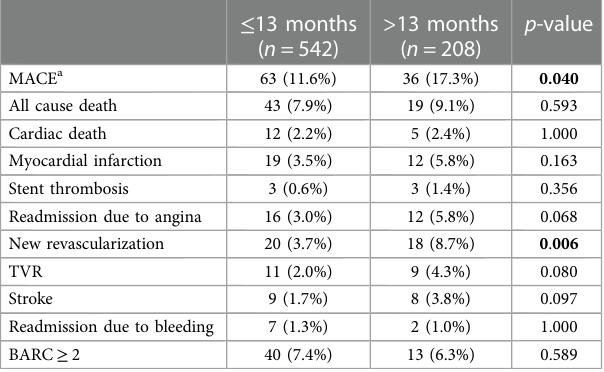
Bold values are statistically signi fi cant values. a MACE (Composite of cardiovascular or all-cause death, nonfatal myocardial infarction, stent thrombosis, and stroke). TVR, target vessel revascularization; BARC, bleeding academic research